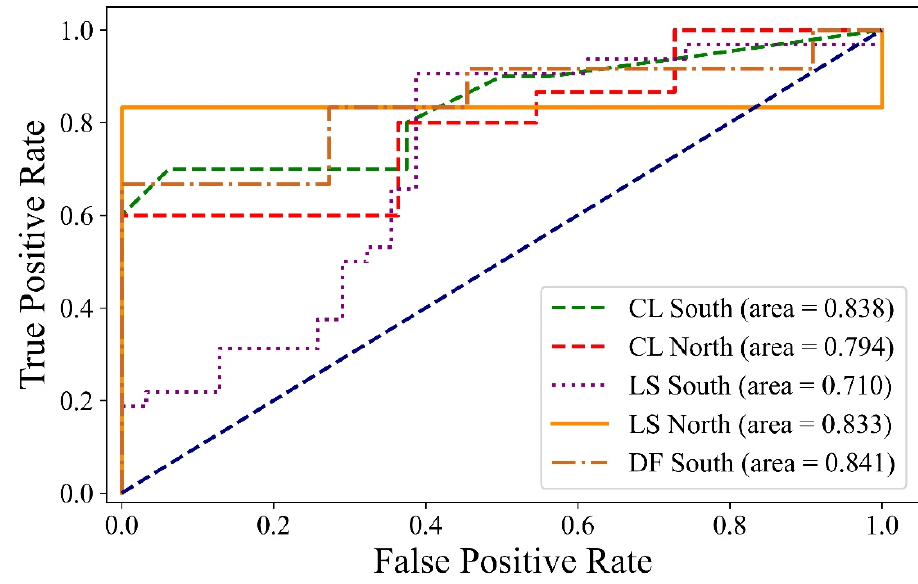
Figure 7. Comparison of ROC curves of Random Forests with collapse (CL), landslide (LS) and debris flow (DF) in Southern and Northern Shaanxi, respectively.